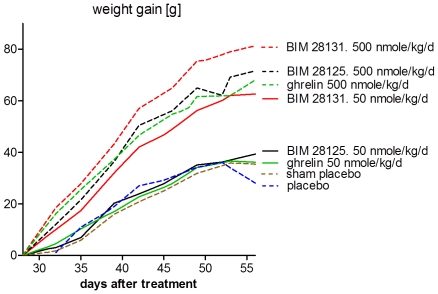
Body weight gain [g] during treatment with ghrelin compounds or placebo (day 28–56).A dose-dependent effect of all compounds was seen. Interestingly, 50 nmole/kg/d BIM-28131 has a higher efficacy than BIM-21125 or human ghrelin at the same dose.